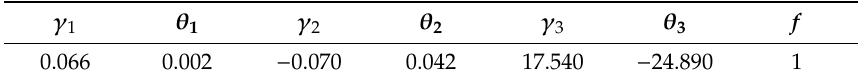
Figure 3. Decomposition of the atmospheric CH 4 concentration data over A 5 . S ( t ), T ( t ), and E ( t ) are the seasonal, trend, and error components, respectively. Two breakpoints were detected in the trend component. The vertical dotted lines in T ( t ) indicate the beginnings of breakpoints (December of 2009 and May of 2012). Table 4. Parameters of S ( t ) shown in Figure 3a and θ i ( i = 1, 2, 3) are the coe ffi cients of the sine and cosine terms, respectively. The unit for γ i and θ i is ppb. f is the frequency (once per